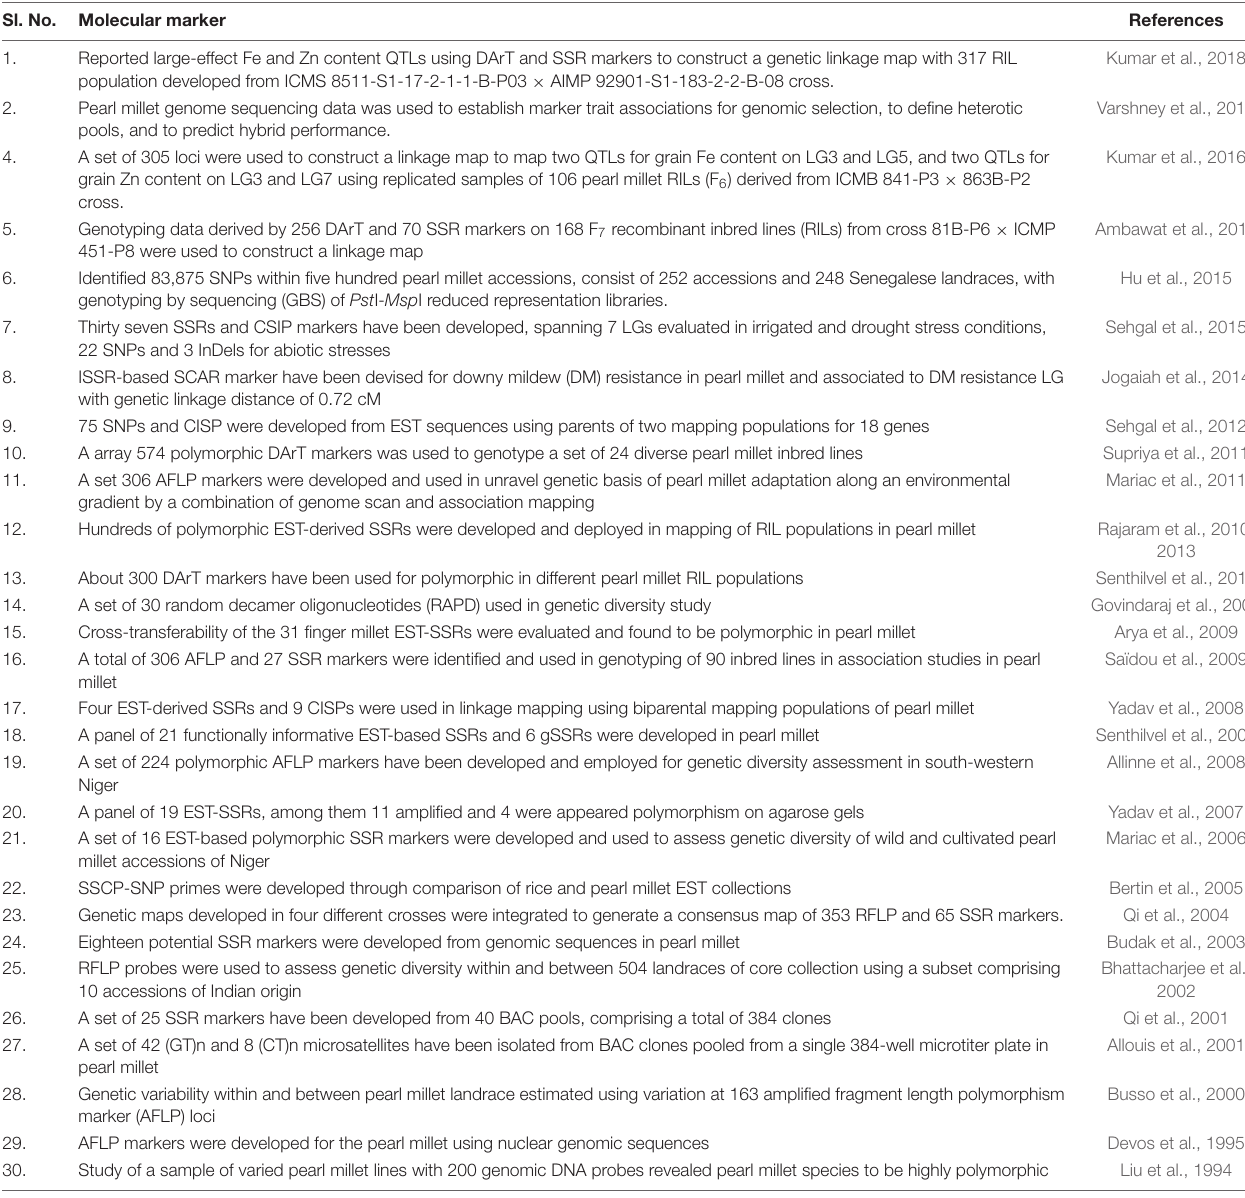
TABLE 2 | Details of molecular markers developed for pearl millet related to genetic diversity, genome mapping, micronutrient, grain yield, fodder biomass, and stress estimation. Sl. No. Molecular